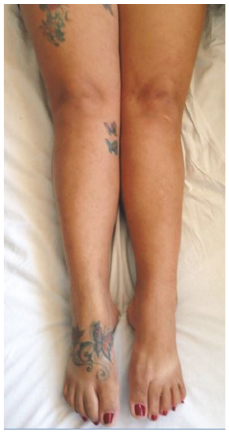
Figure 5: Case 6: patient without edema after recovered DVT in right